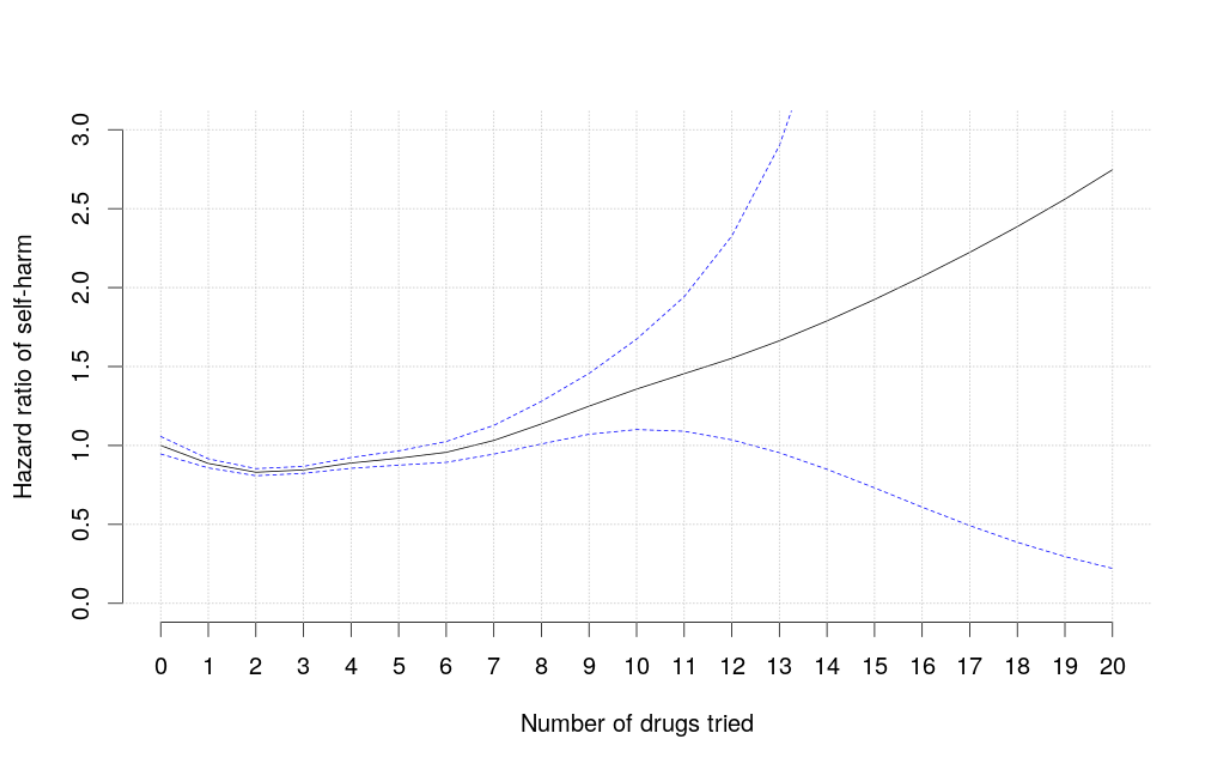
Figure 3. The hazard ratio of coded and/or imputed self-harm as a function of the number of different unique drugs of interest used by the patient in the year prior to the index visit plus up to the prior treatment interval. The graph represents a smoothing spline, with the reference being zero prior drugs. The blue dotted lines represent 95%